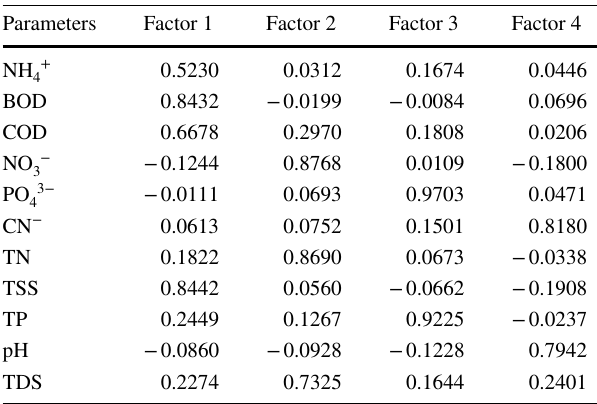
Table 4 Loadings of main 4 factors after Varimax rotation